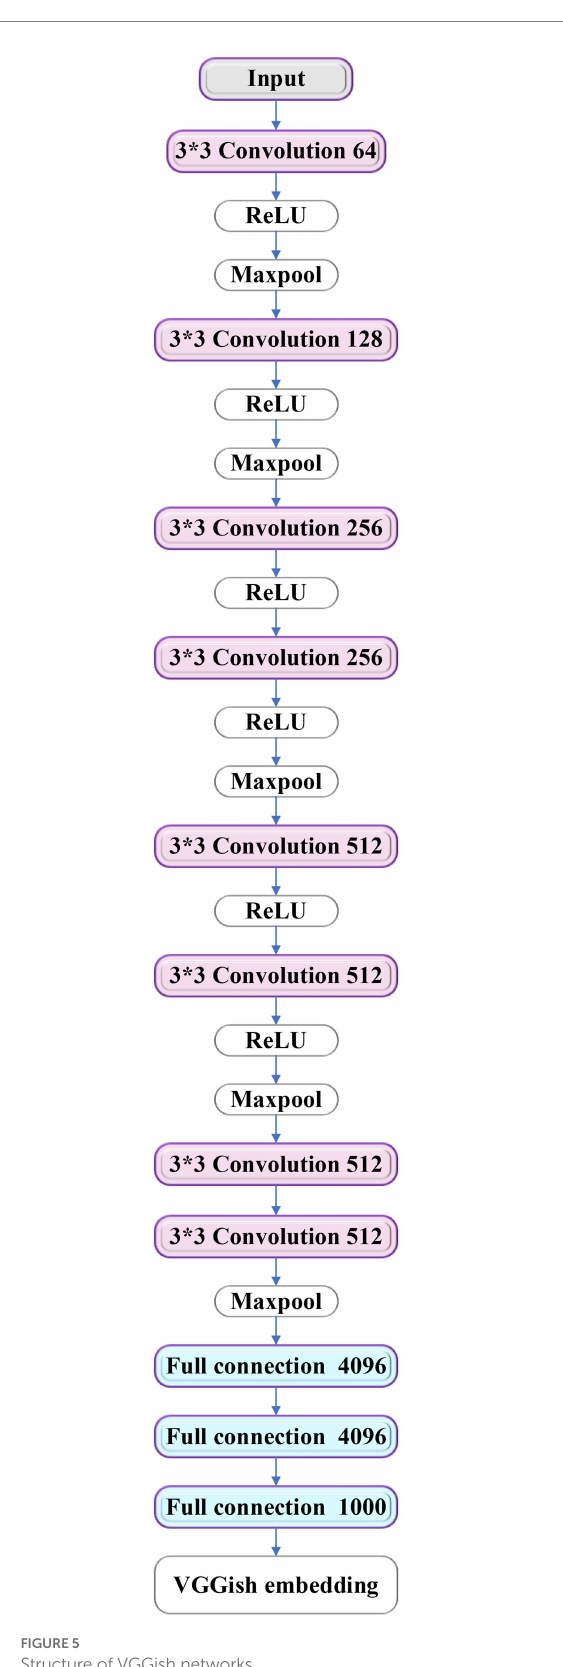
FIGURE 5 Structure of VGGish networks.